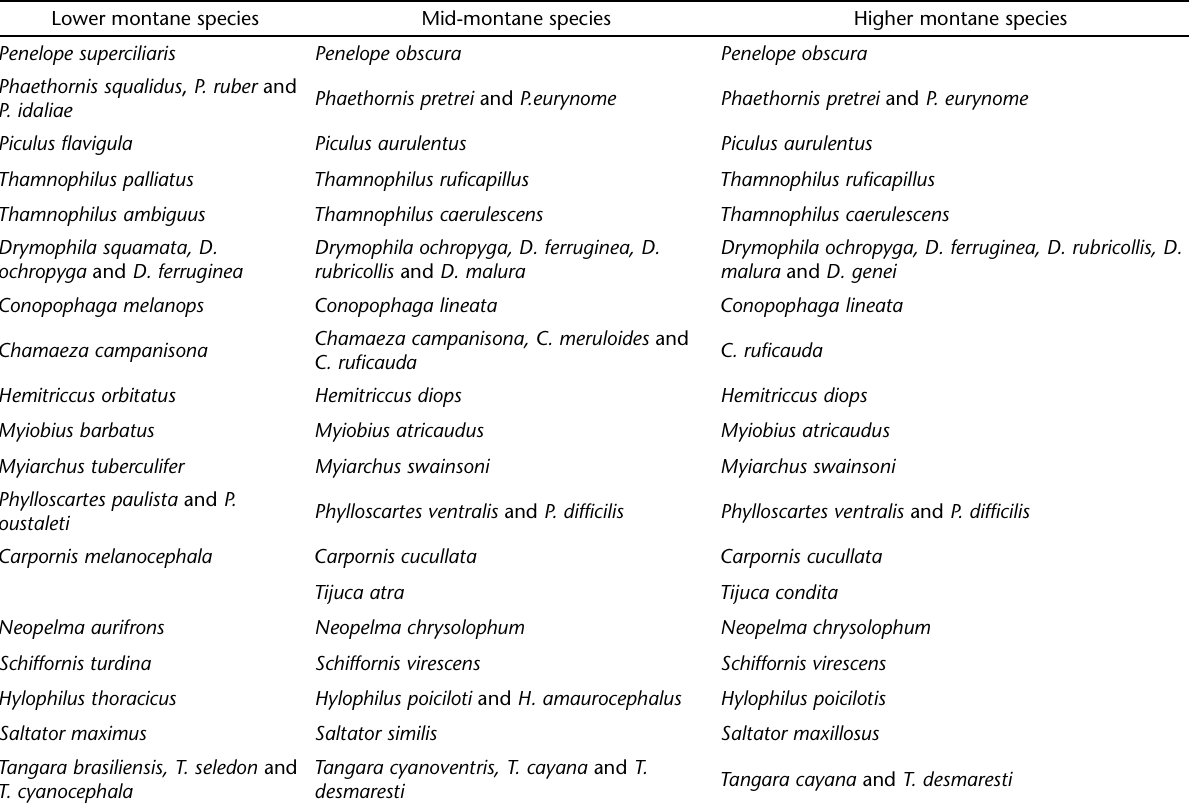
Table I. Congeneric bird species with altitudinal replacement in the Serra dos Órgãos, southeastern Brazil. Lower montane